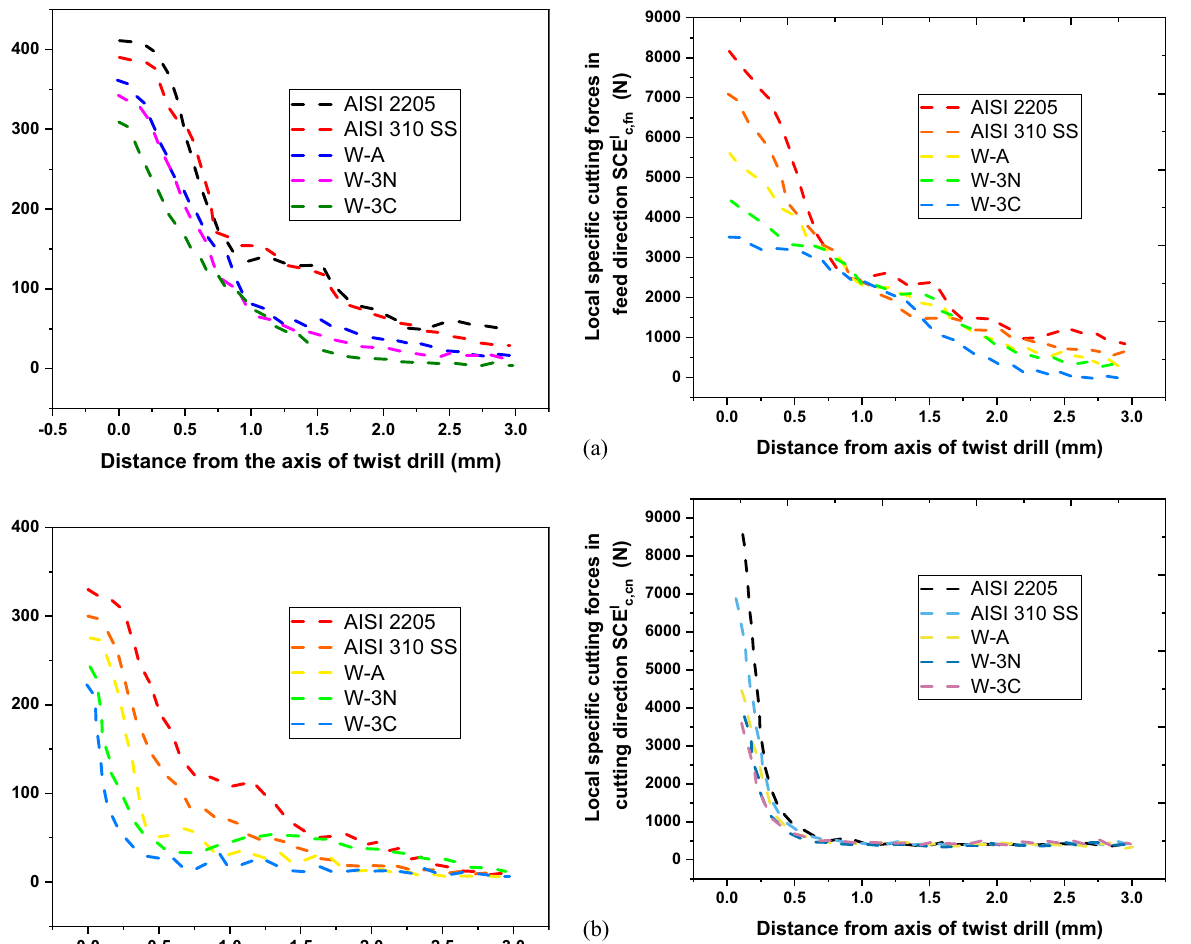
Figure 12: ( a ) Variations in SCE l c,fn from drill axis to periphery. ( b ) Variations in SCE l c,fc from drill axis to Figure 11: ( a ) Variations in feed force LF f from drill axis to periphery. ( b ) Variations in cutting force LF c from drill axis to periphery.